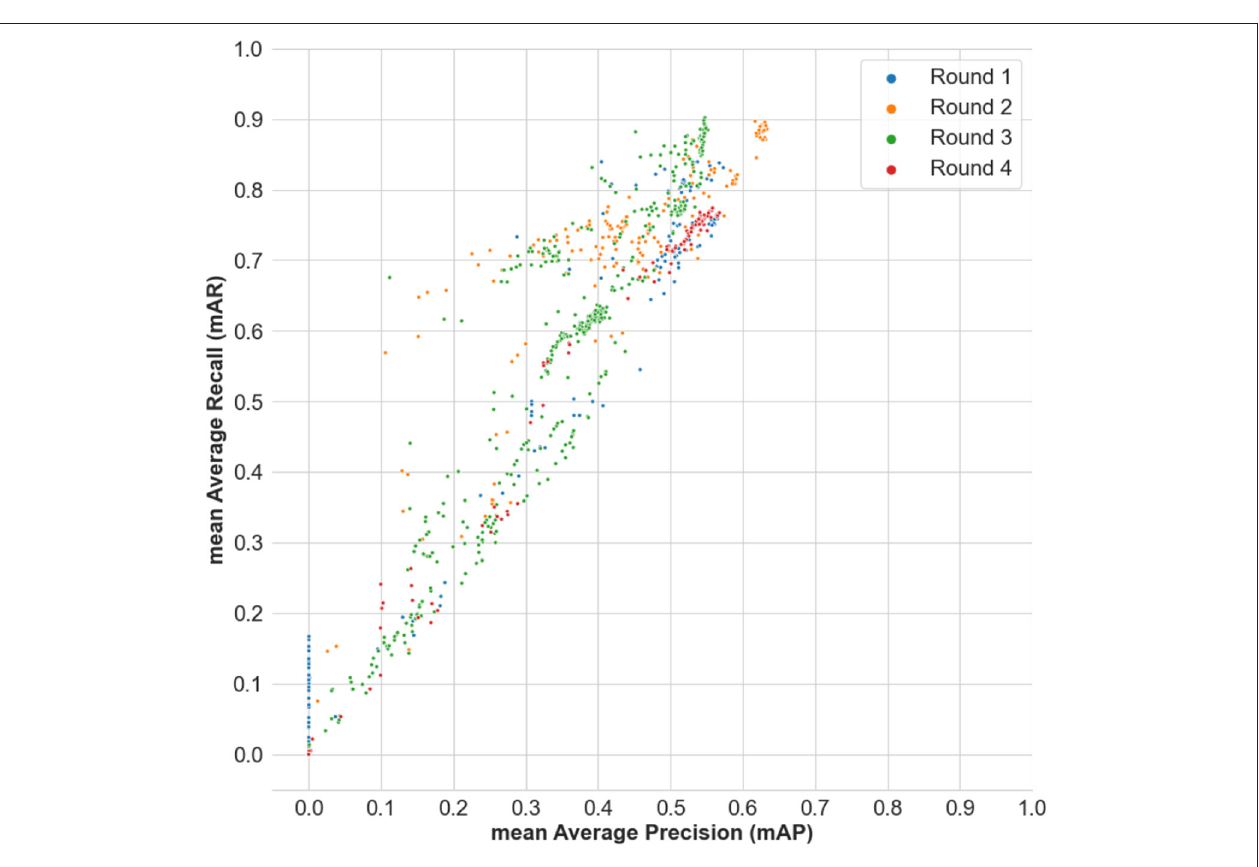
FIGURE 9 | Distribution of the mean Average Precision (mAP) scores and the mean Average Recall (mAR) scores across all the submissions made in the